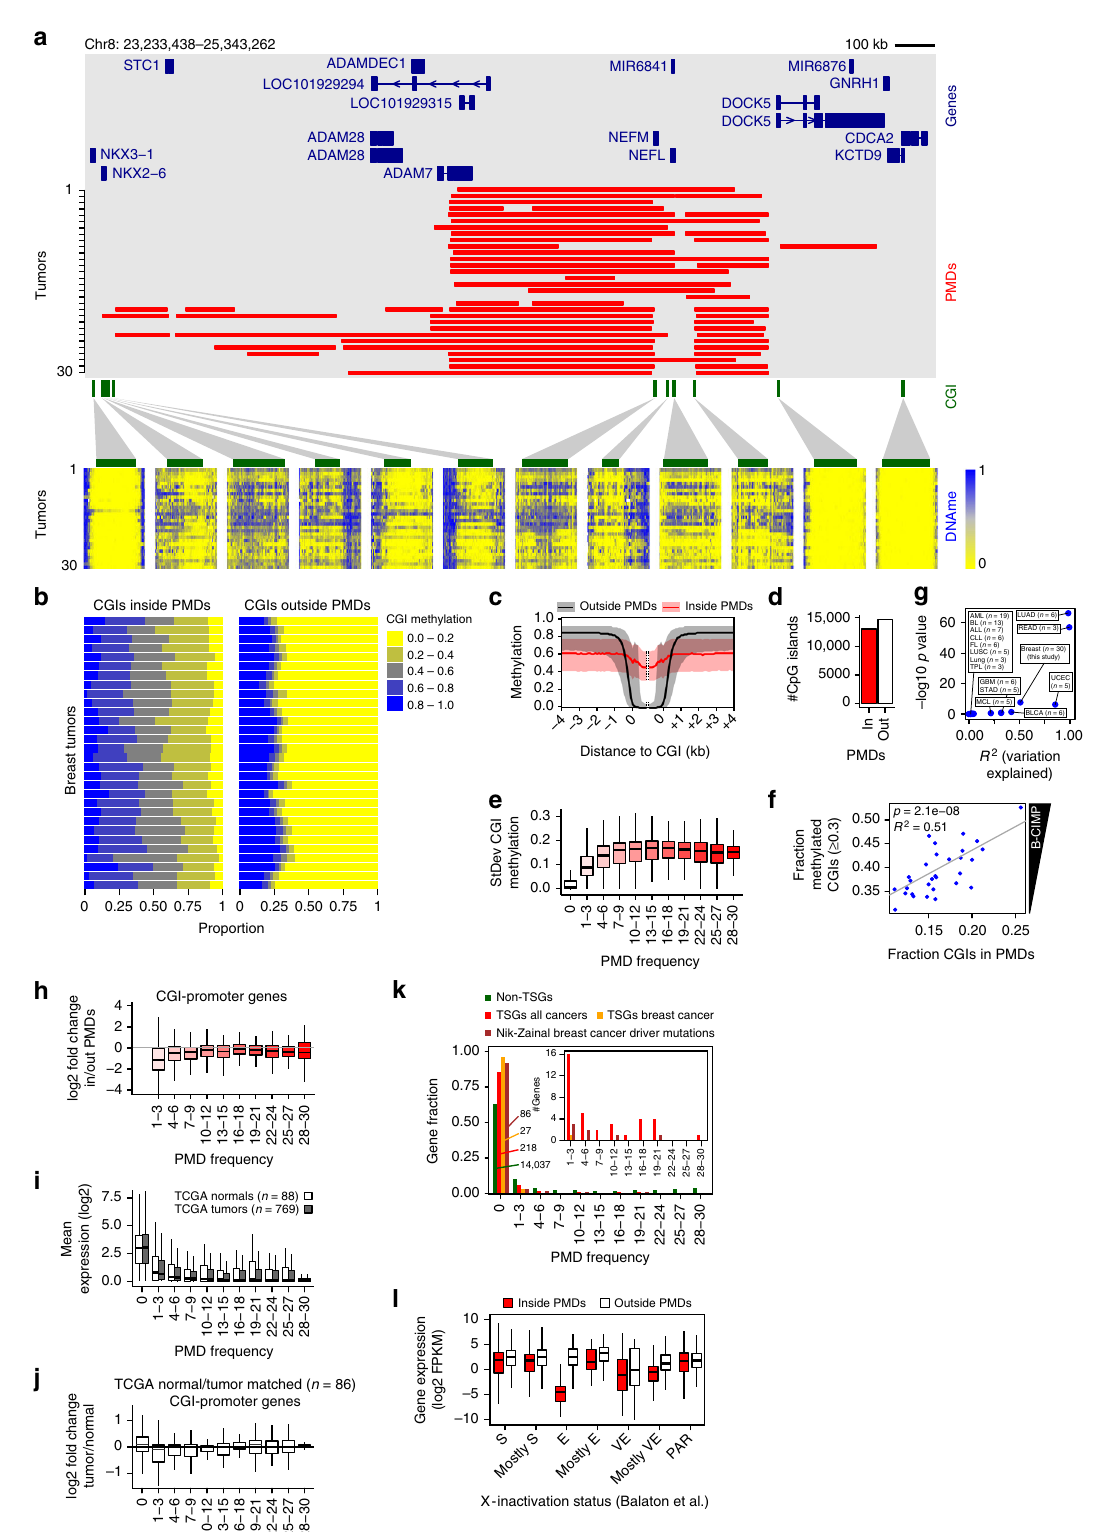
breast cancer-mutated genes were not excluded from PMDs. We (Supplementary Fig. 7C). For 16 out of these 24 genes we assessed whether these genes are downregulated in tumors when con fi rmed that signi fi cant downregulation also takes place in inside PMDs. 24/31 (74%) genes were downregulated (Supple- cancer relative to normal in an independent breast cancer mentary Fig. 7A, B), and an overall negative correlation between expression dataset (TCGA, see examples in Supplementary CGI-promoter methylation and expression was evident Fig. 7D). Among the downregulated genes in PMDs are EGFR NATURE COMMUNICATIONS| (2019) 10:1749